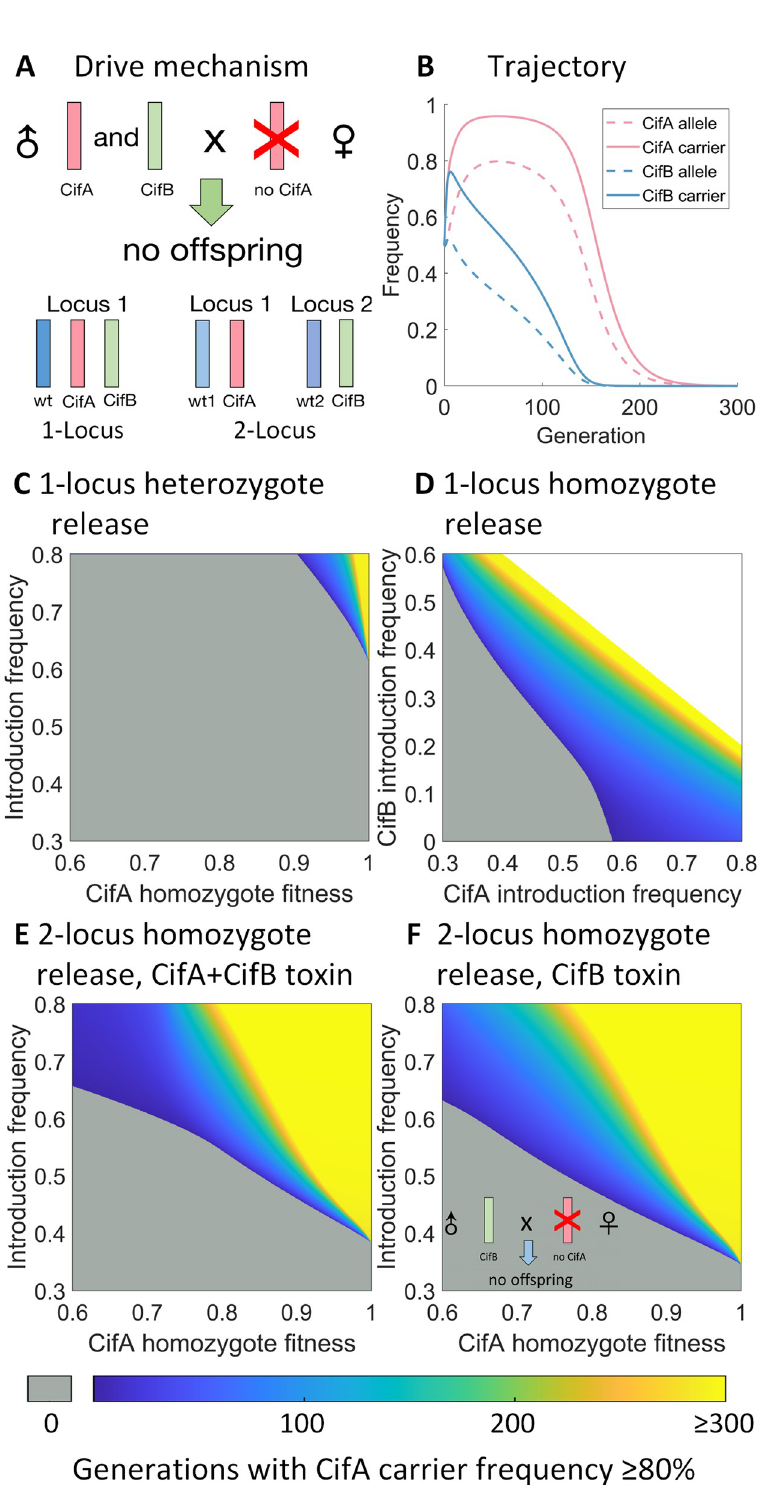
Fig 6. Characteristics of self-limiting variants. All homozygous fitness costs are on cifA allele and are 0.95 unless otherwise specified. A : When male cifA and cifB carriers mate with females lacking cifA , no viable offspring is produced (B-E). We model scenarios where cifA and cifB alleles must share the same locus (C-D) or are on separate genetically unlinked loci (B,E-F). B : Trajectories of allele and carrier frequencies. We use a homozygote introduction frequency of 0.5. C : A 1-locus cifA / cifB heterozygote release. D : A 1-locus homozygote release. E : A